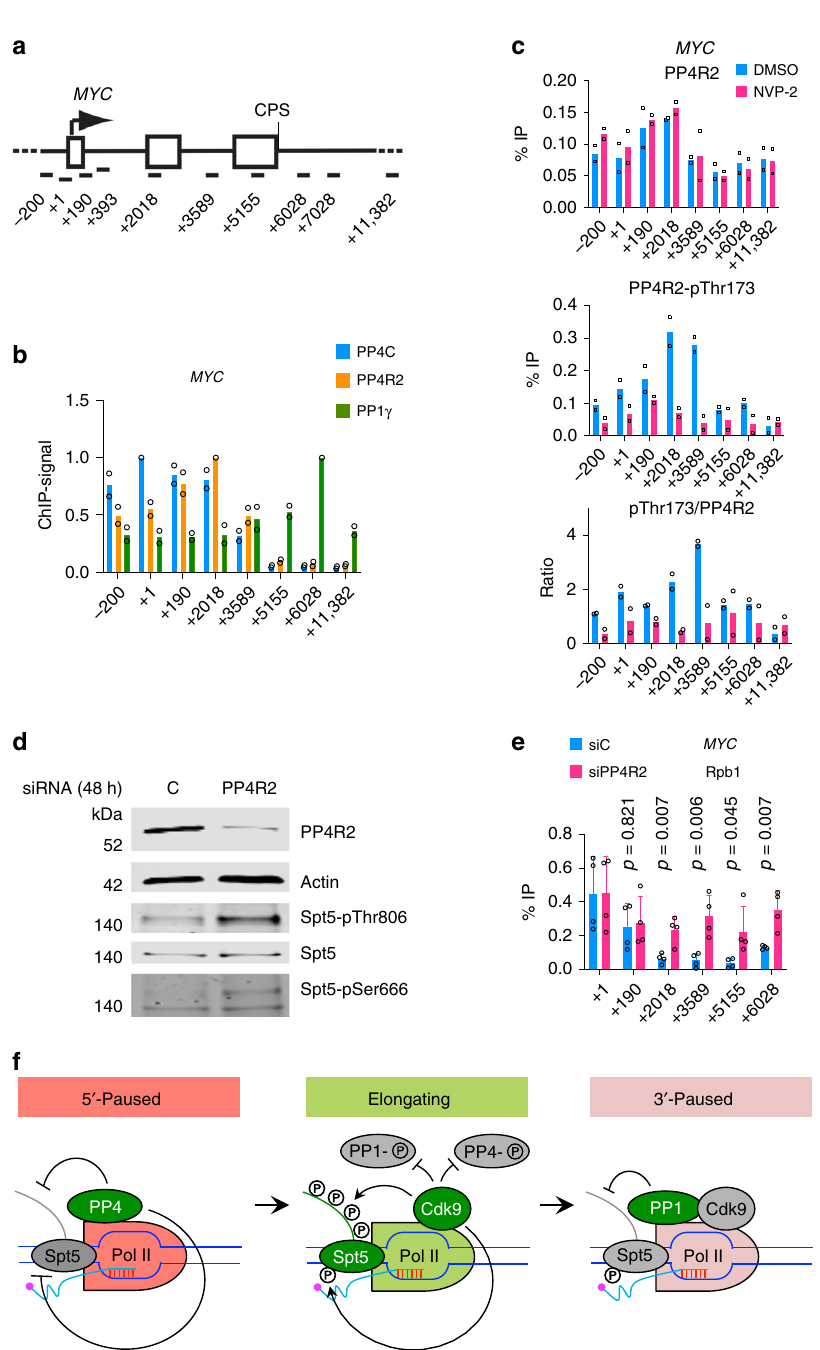
Fig. 7 Two Cdk9-regulated phosphatases help order the transcription cycle. a Schematic of the MYC gene, indicating positions of primer pairs used in ChIP-qPCR analysis. b ChIP-qPCR analysis of PP4C, PP4R2, and PP1 γ on the MYC gene in unperturbed HCT116 cells ( n = 2 biological replicates). c ChIP- qPCR analysis of PP4R2 and PP4R2-pThr173 after inhibition of Cdk9 with NVP-2 (250 nM) or mock treatment (DMSO) for 1 h ( n = 2 biological replicates). d Cells transfected with siRNA targeting PP4R2 or nontargeted negative control siRNA were subjected to formaldehyde cross-linking, chromatin isolation, and reversal of cross-linking before analysis by immunoblotting with indicated antibodies to measure the depletion of PP4R2 and phosphorylation of Spt5 at Ser666 and Thr806. e ChIP-qPCR analysis on MYC shows Pol II distribution with or without PP4R2 depletion. Error bars ( + s.d.) and p values were calculated by two-sided Student ’ s t test from four biological replicates ( n = 4); individual data points from biological replicates are shown in the plots ( b , c , and e ). f Two distinct Cdk9-phosphatase switches govern transitions in Spt5-phosphorylation state — a model. At the 5 ′ pause prior to P-TEFb activation, the PP4 complex is active and both CTR1 and the KOW4 – KOW5 loop are unphosphorylated, At the 3 ′ pause, PP1 becomes active to dephosphorylate CTR1 but not Ser666, distinguishing the two paused complexes. During elongation, Cdk9 phosphorylates Spt5, and inhibits PP4 and PP1. Source data are provided as a Source data fi